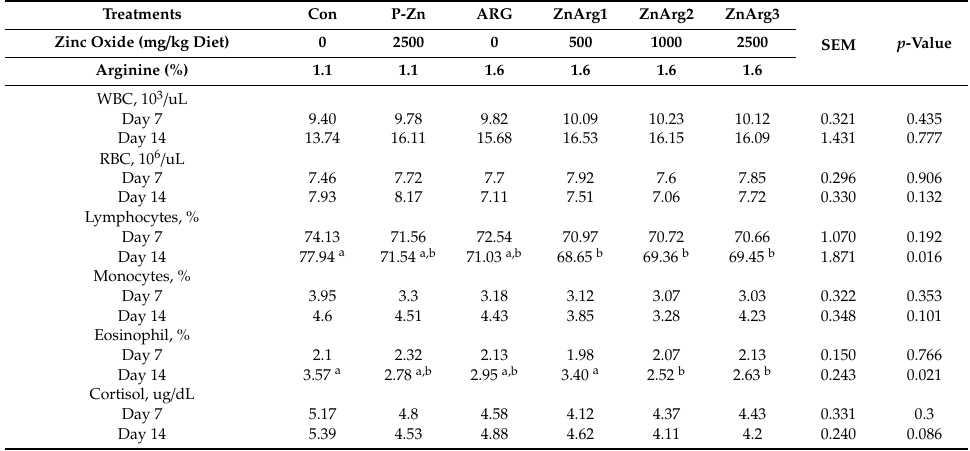
Table 6. E ff ect of dietary zinc and arginine on blood characteristics of weanling piglets exposed to high